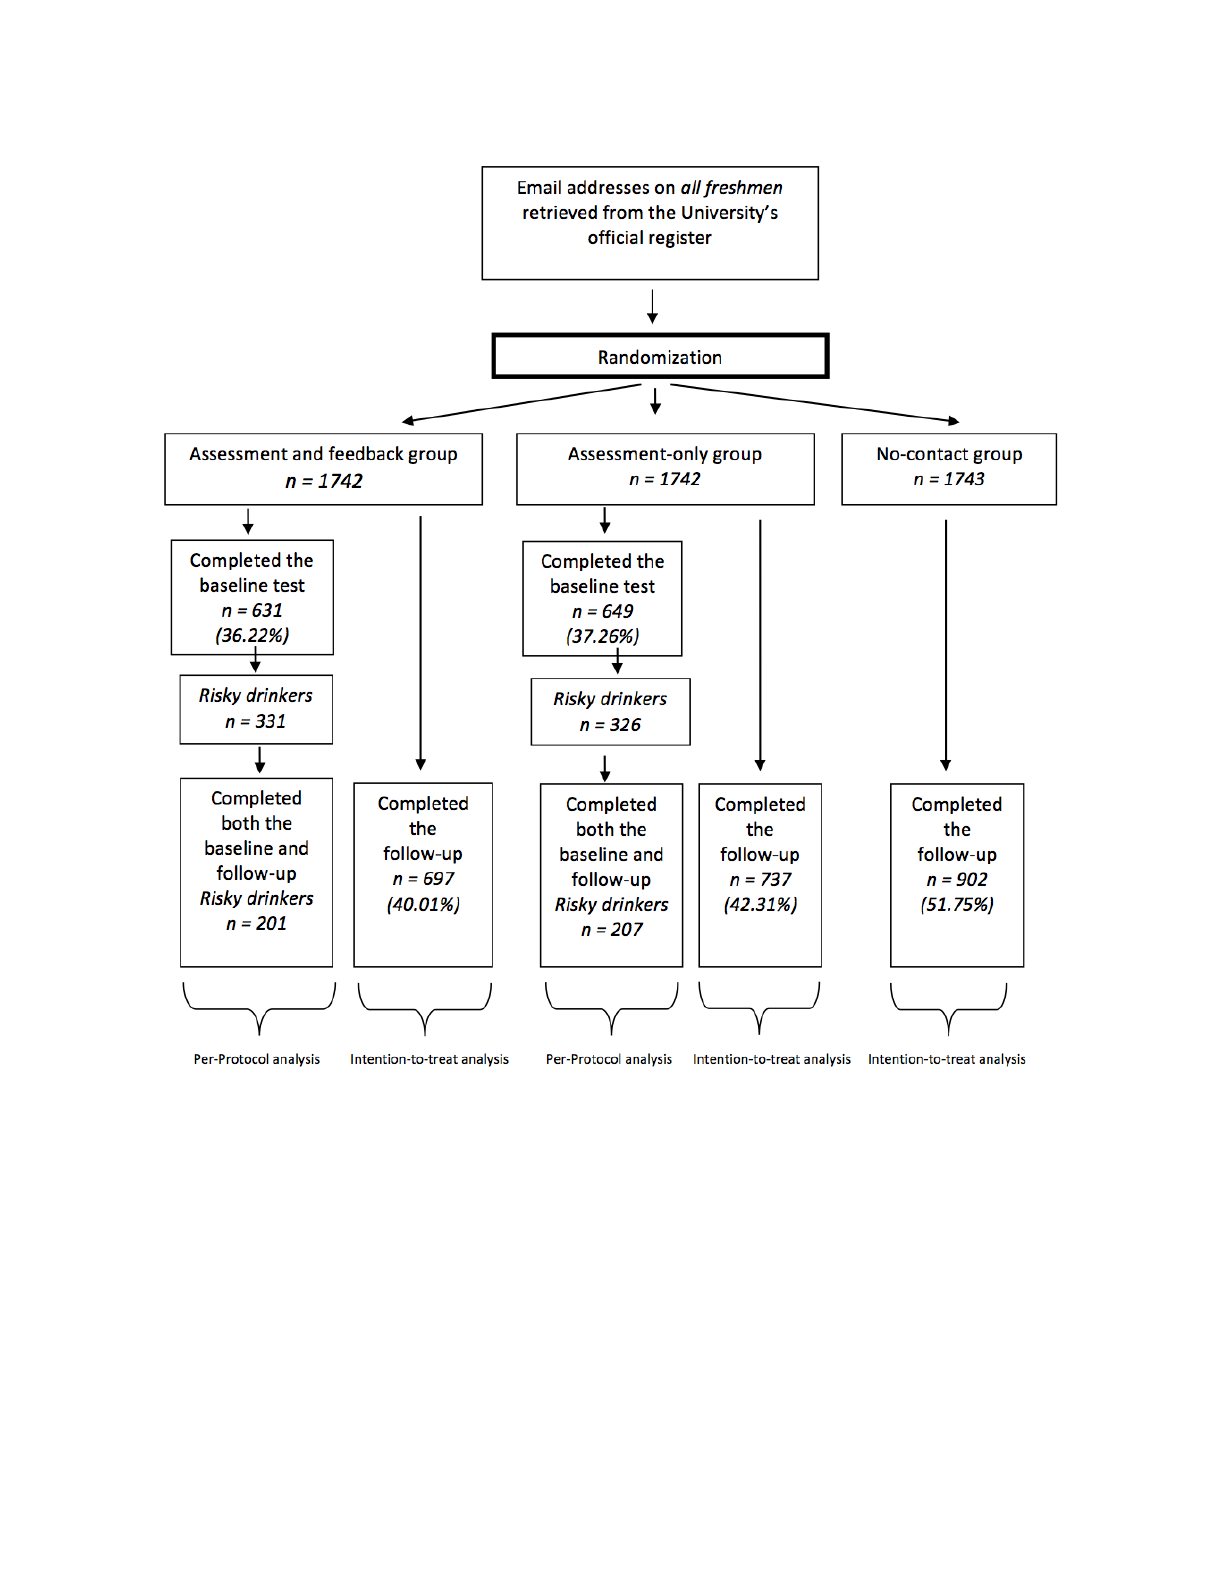
Figure 1. CONSORT flowchart for the